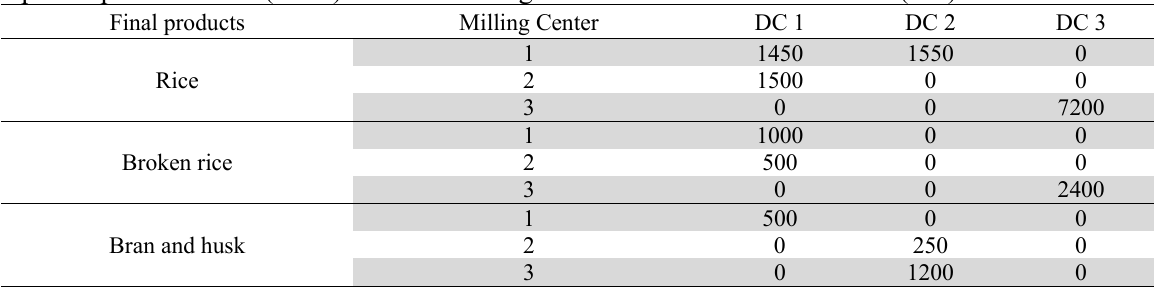
Optimal product flows (tones) between milling centers and distribution centers (DC)